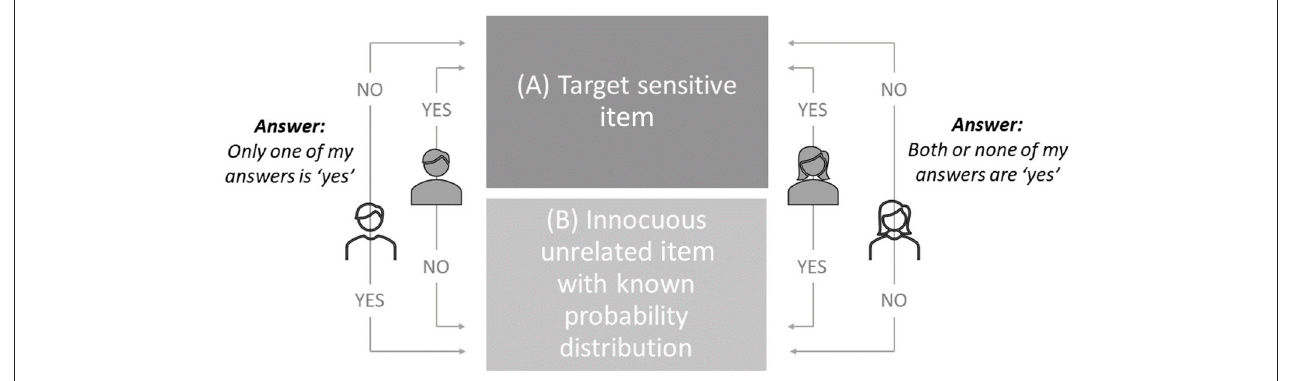
FIGURE 1 | Conceptual framework of